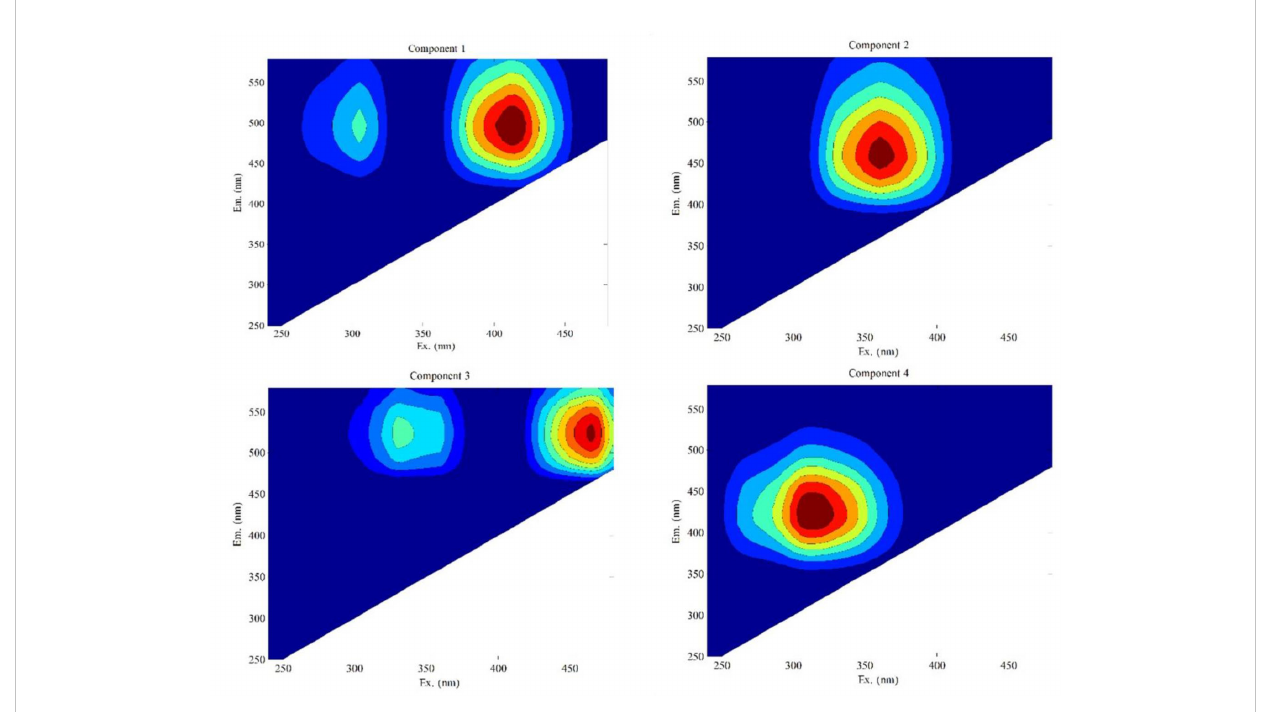
FIGURE 3 Fluorescence signatures of the four identi fi ed EEMs-PARAFAC components. EEMs-PARAFAC, fl uorescence excitation – emission matrix spectroscopy – parallel factor